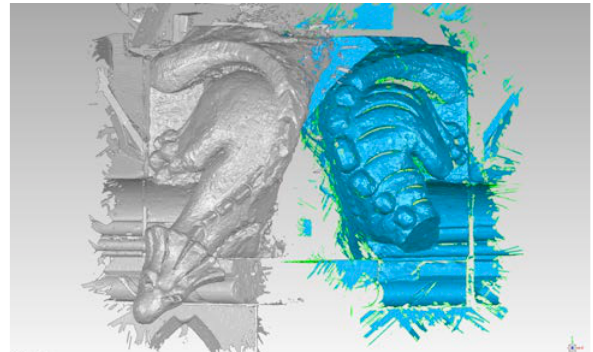
Figure 9 . Adjacent Grotesques with and without